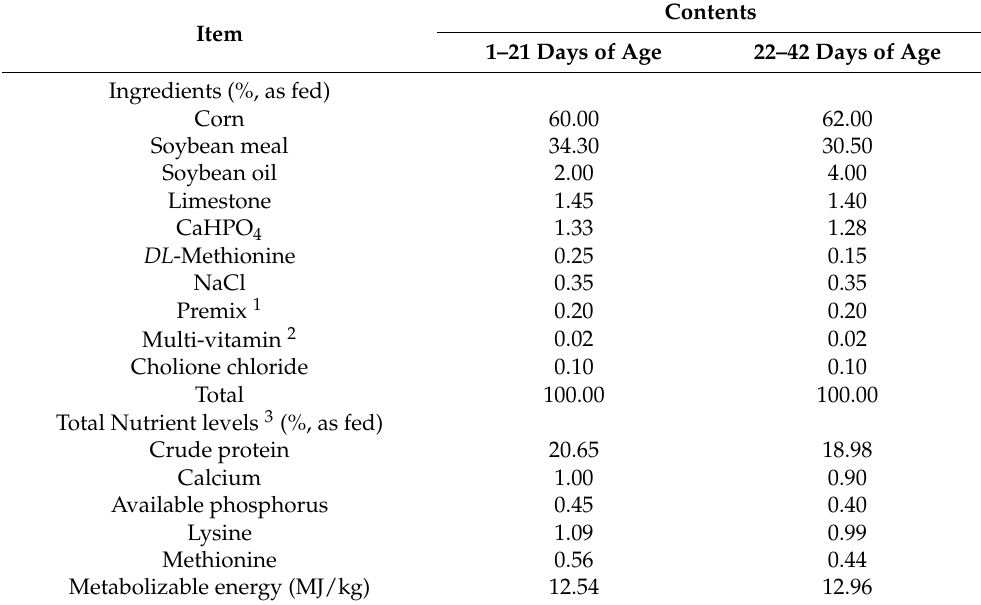
Table 1. Ingredients and nutrient levels in the basal